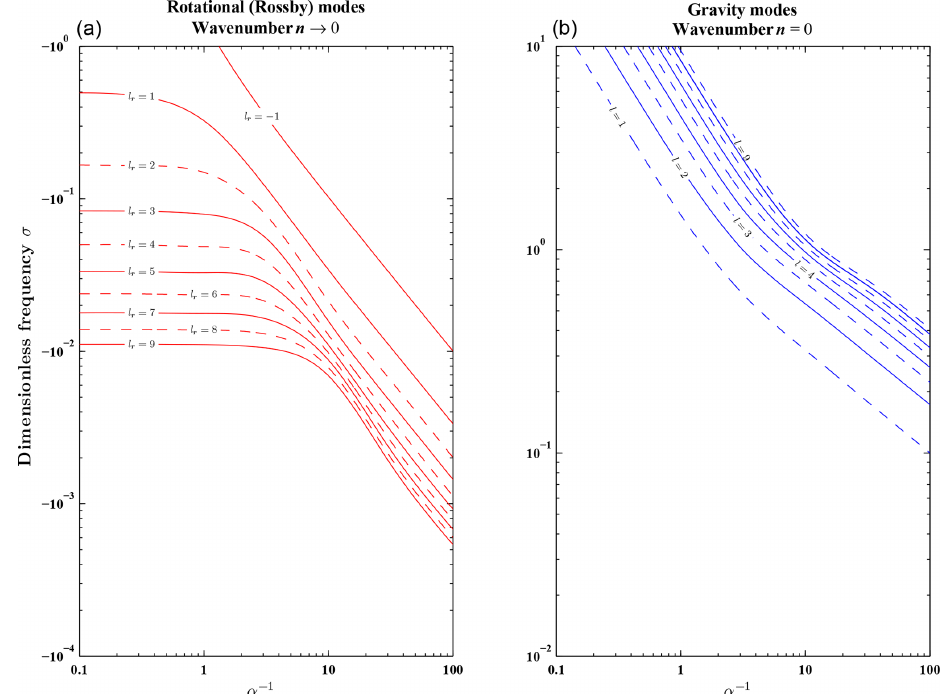
Figure 5. Asymptotic dimensionless frequencies σ a in the case of n → 0 (a) and dimensionless frequencies | σ | for gravity waves and zonal wavenumber n = 0 (b) , plotted as a function of α − 1